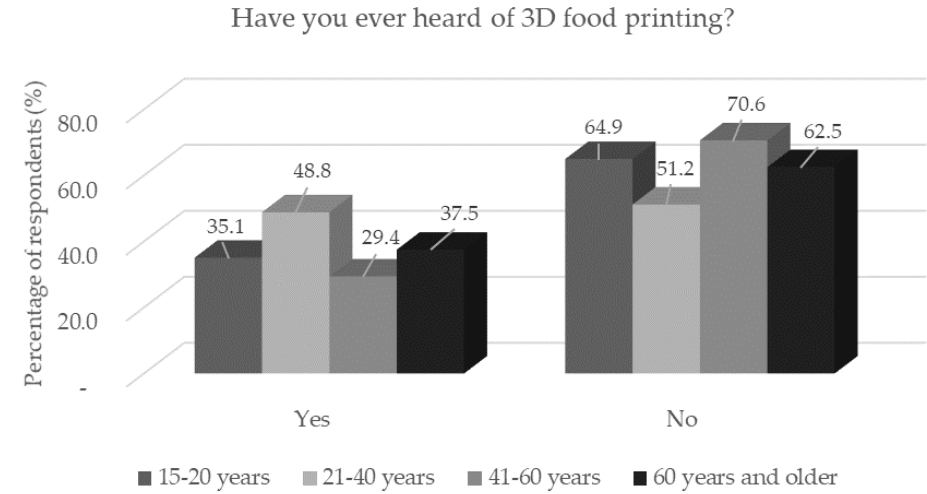
Figure 2. Respondents’ awareness of 3D food printing ( n = 1156) by age category in response to the question: “Have you ever heard of 3D food printing?”.